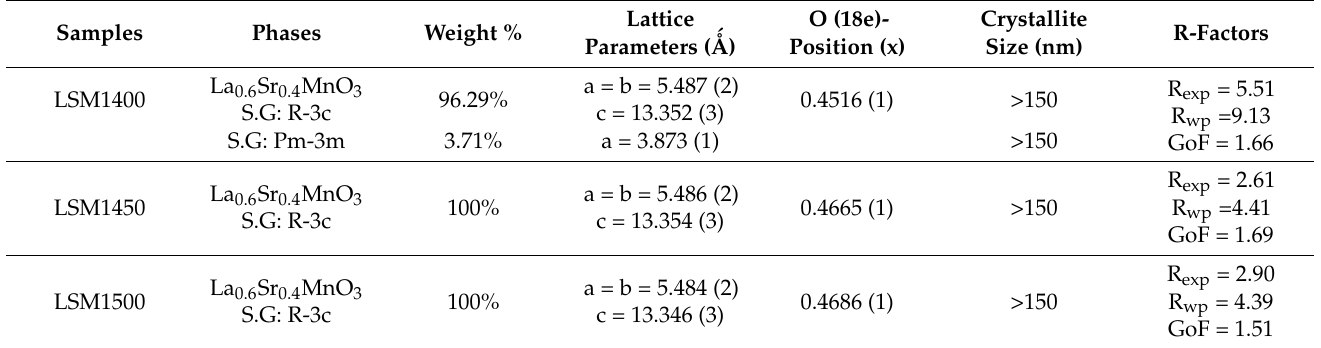
Table 1. Quantitative analysis of phases and microstructural parameters obtained using Rietveld refinement of LSM